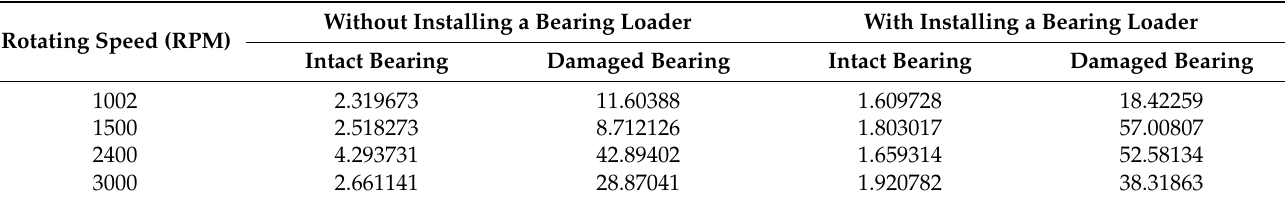
Table 6. Averaged kurtosis values for a ball defect.